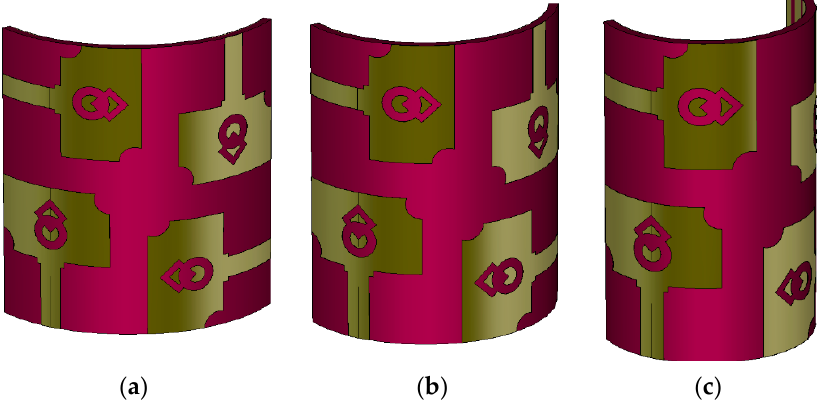
Figure 17. Bending analysis of the antenna at three bending radii ( a ) BR = 25 mm, ( b ) BR = 20 mm, ( c ) BR = 15 mm.